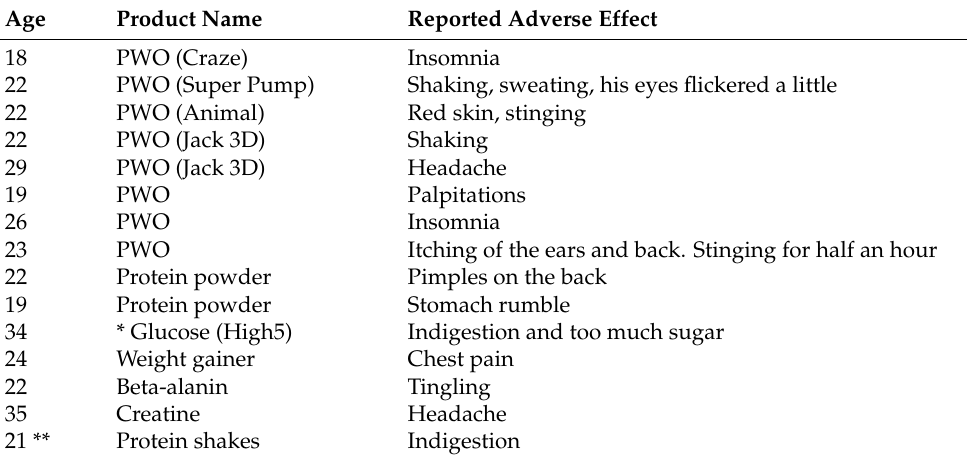
Table 4. Reported adverse effects among fifteen participants able to recall the products most likely associated with the